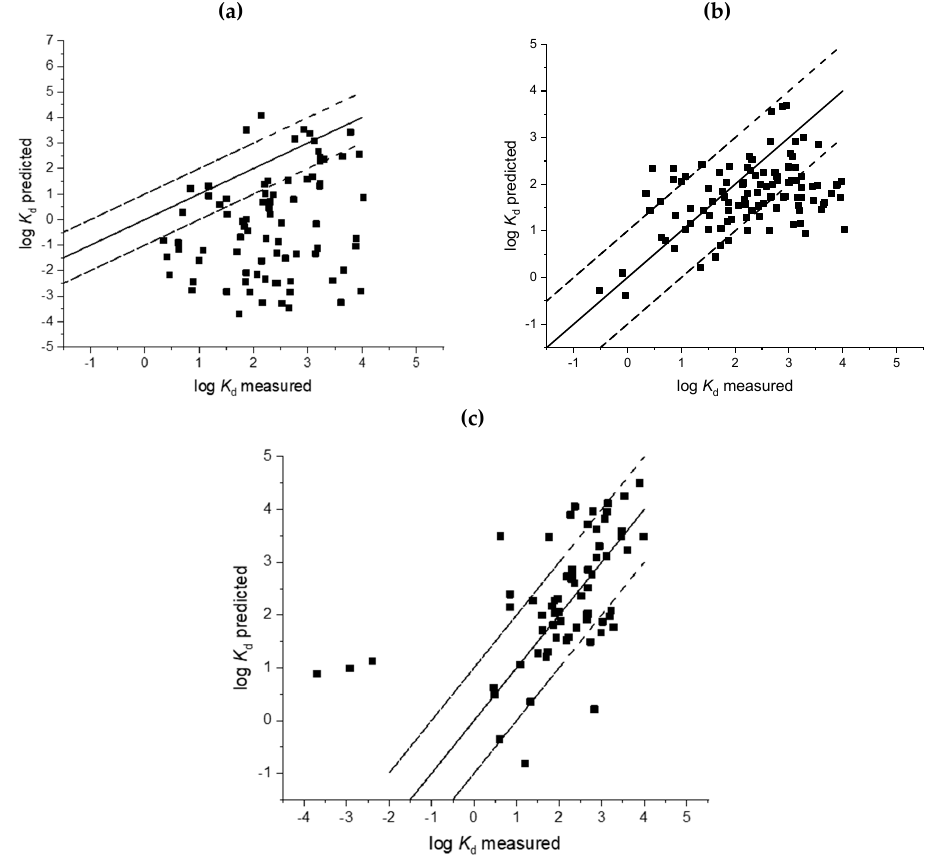
Figure 3. Comparison of predicted and measured soil sorption coefficients (log K d ) for basic pharmaceuticals Bintein and Devillers [28] ( a ); Franco et al. [31] ( b ); Droge and Goss [30] ( c ). Comparatively, the Droge and Goss model [30] resulted in the best model performance for the prediction of sorption coefficients for pharmaceuticals with a basic functional group. Comparison of predicted and measured sorption coefficients resulted in a relatively small deviation from the 1:1 line and 71% of the predicted log K d values were within one log unit of the corresponding measured log K d value (Figure 3 and Table 3). There is a larger spread of data around the 1:1 line for pharmaceuticals from the iPiE database as compared with the dataset used to evaluate the model in the original paper, where it was observed that most K d predictions were within a factor of three [30]. The Droge and Goss model [30] was also able to capture a larger proportion of the variance in the measured data with a relatively high r 2 of 0.29. However, a large RMSE of 0.79 (Table 3) suggests that there is a need to improve this prediction further and reduce the associated standard deviation of unexplained variance. Even though all models evaluated here resulted in low r 2 values (<0.29, Table 3), the results show that approaches that consider the charge of the chemical in combination with information on selected soil properties perform better than the K ow -based models. This finding is in agreement with previous studies which have concluded that, based on advances in our mechanistic understanding, multiple reactive sites, in addition to organic matter, are important for ionisable chemical sorption [11,39]. For example, oxytetracycline can sorb to soils via a number of mechanisms including cation exchange and cation bridging to negatively charged sites on both aluminosilicates and organic matter, as well as complexation to iron and aluminium ions on metal oxides. Models that also included